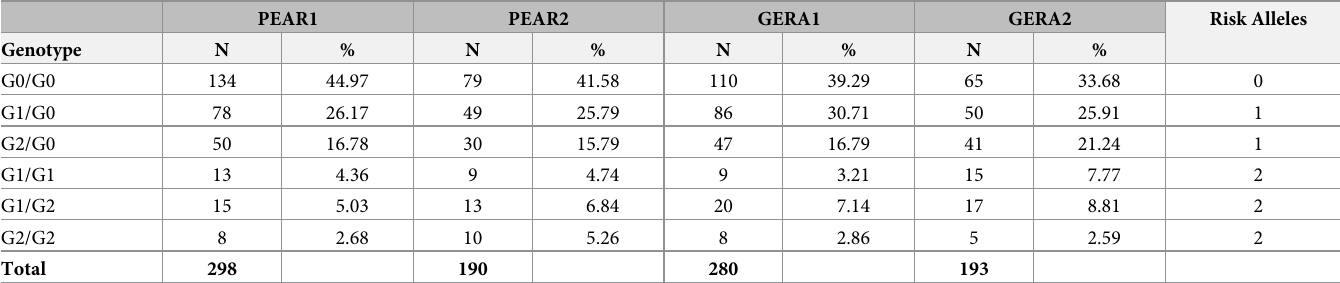
Table 2. APOL1 genotype frequencies by